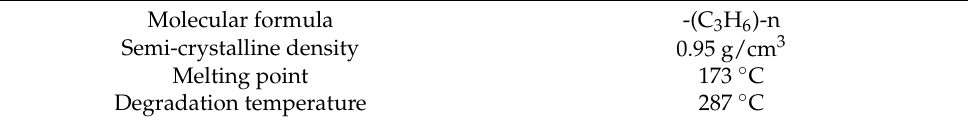
Table 1. Properties of the polymer used for the impregnation